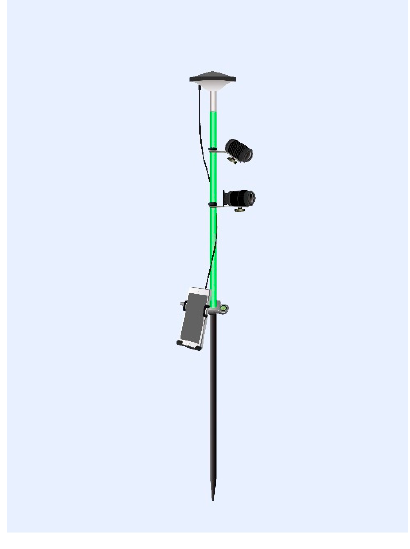
Figure 3. Surface photogrammetry appearance.